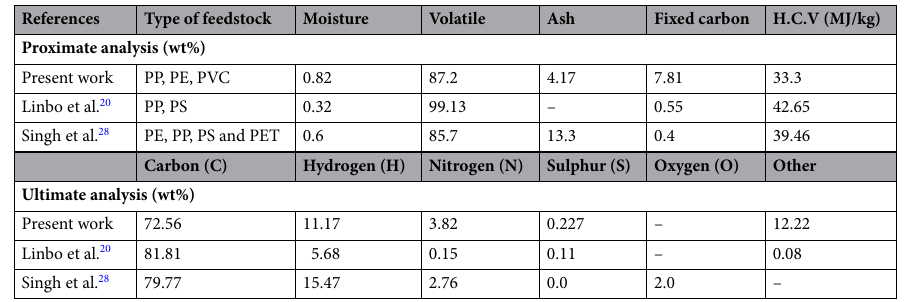
Table 1. Proximate and ultimate analysis of plastic based medical wastes.